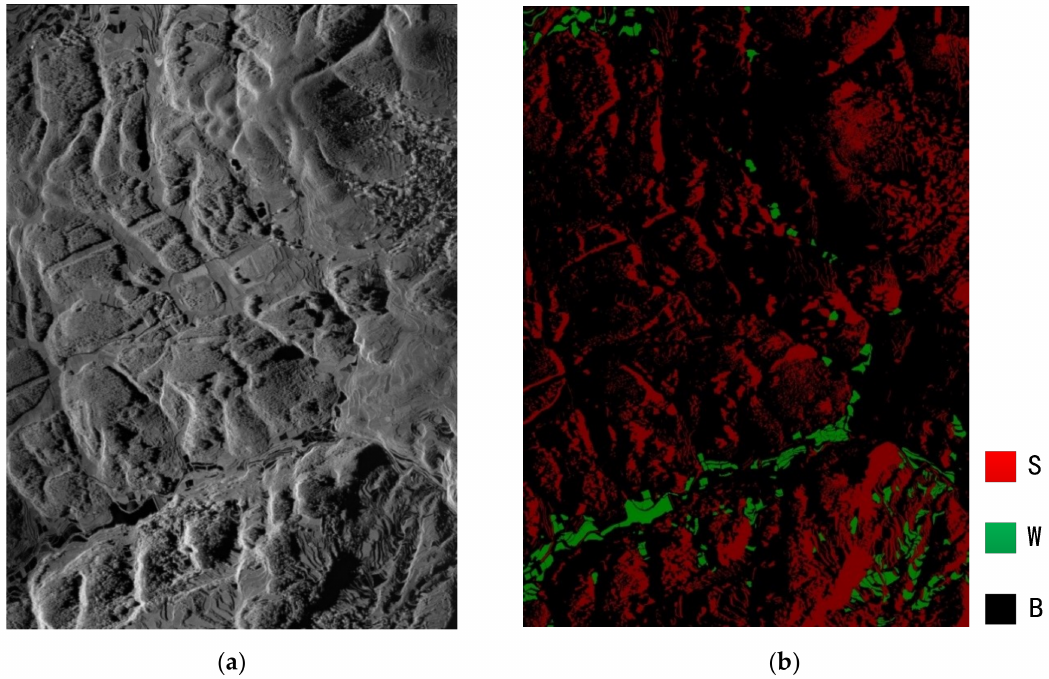
Figure 1. ( a ) the large-scale SAR image. ( b ) The corresponding ground truth of the SAR image. ‘S’, ‘W’, and ‘B’ denote ‘Shadow’, ‘Water’, and ‘Background’